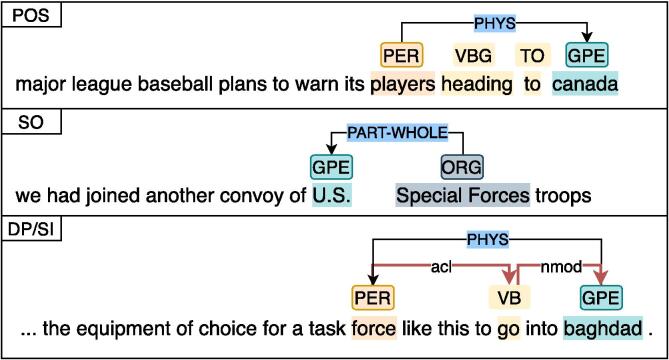
Missing predictions when removing a component, which is named in white box on the top left corner, compared to SIWRsELMo. Other POS tags, dependency connections and relations are obmitted for simplicity.